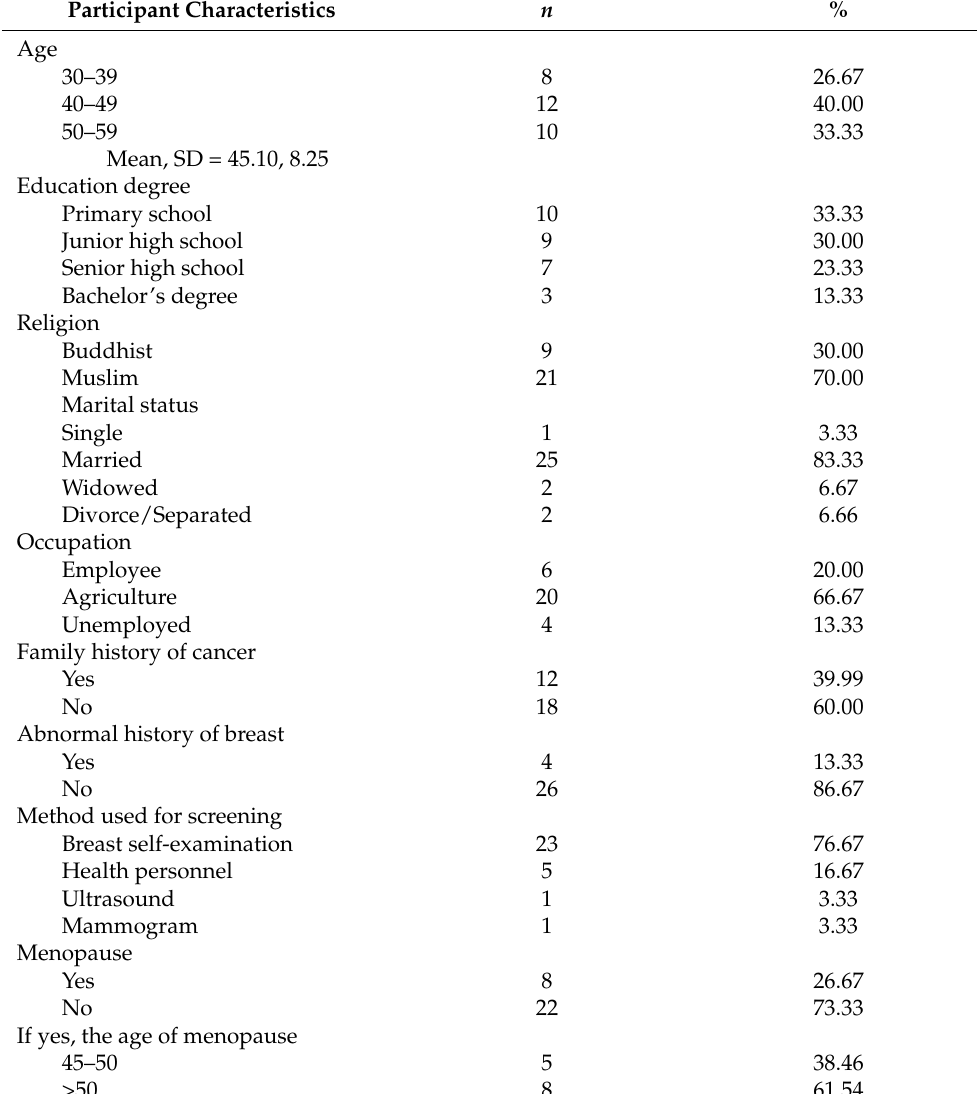
Table 1. The characteristics of research participants (n =